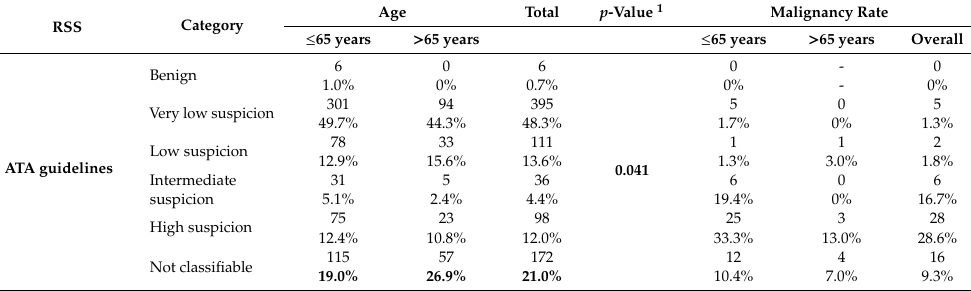
Table 2. Distribution of risk classes according to 5 sonographic classification systems and actual malignancy rate in the two age